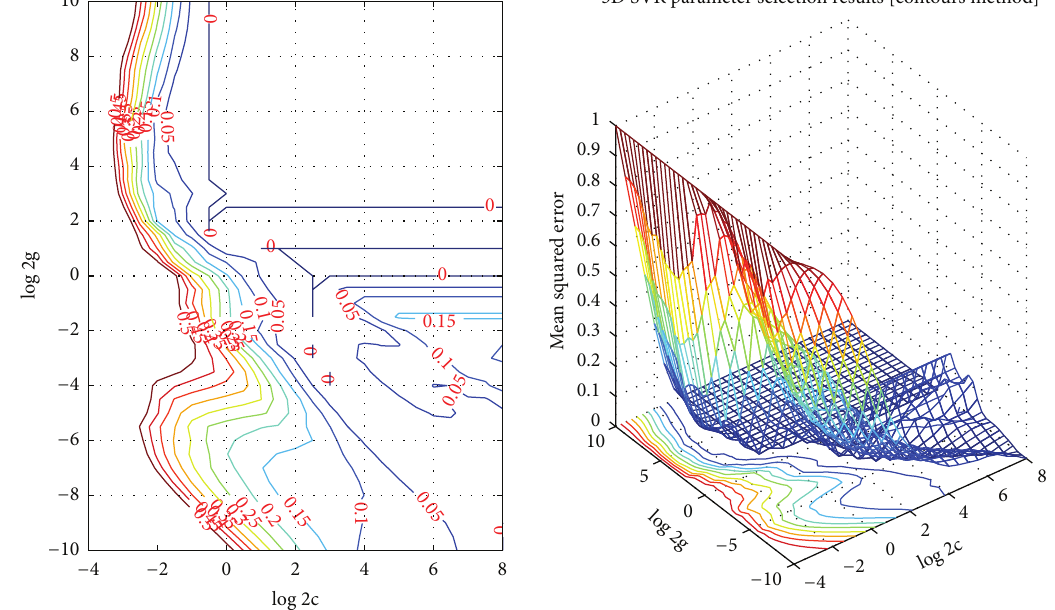
Figure 9: 2D and 3D parameter selection results. (Grid-search method and contours method, PF).